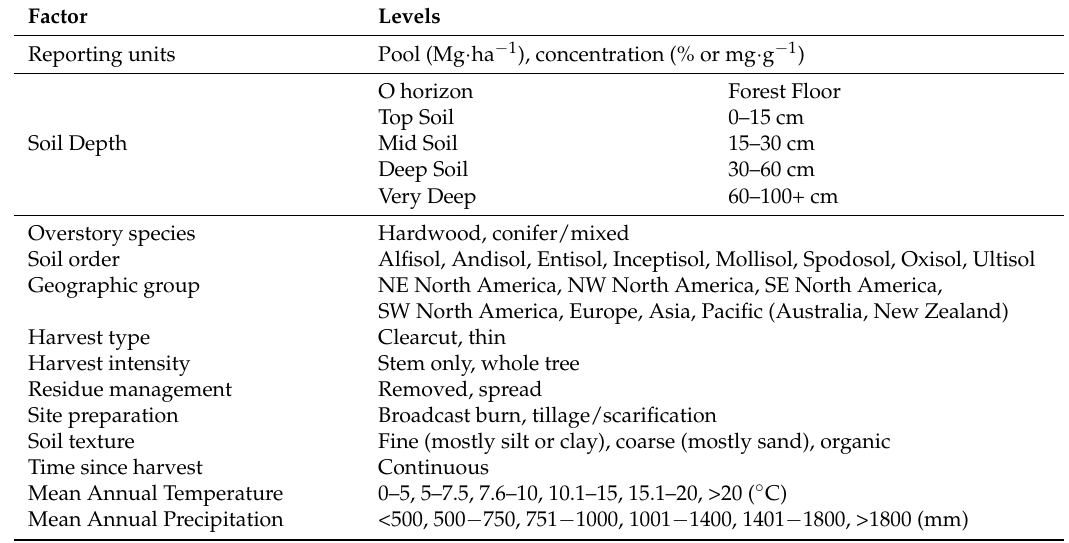
Table 1. Factors gathered as potential predictor variables in this